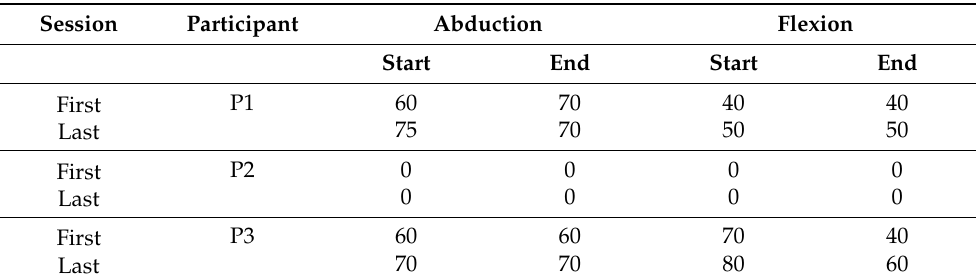
Table 3. Summary of the goniometry data for range of motion (ROM), measured in degrees. “First” and “Last” represent the first and last training sessions for which these data were acquired, respec- tively, while “Start” and “End” represent the beginning and end of a given session, respectively. Larger values indicate more flexible movements.